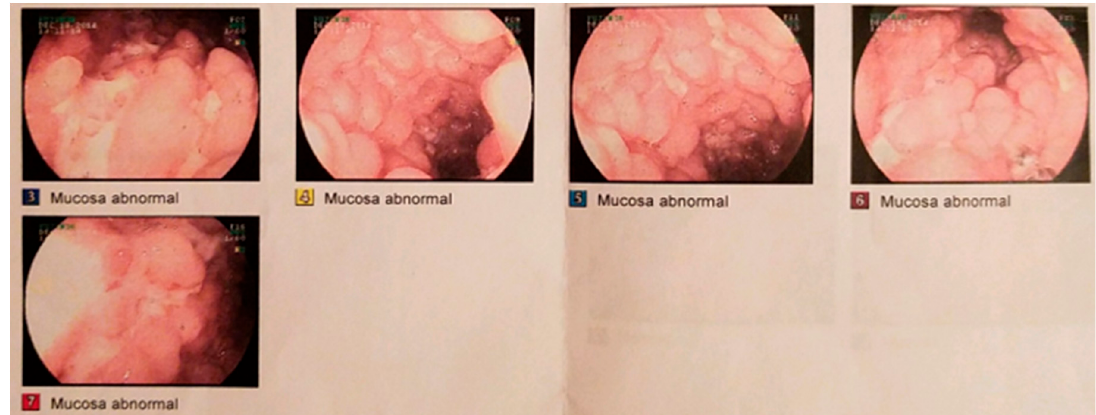
Figure 1. Photographs from diagnostic ileo-colonoscopy in December 2014: inflamed terminal ileum with the typical cobble stone mucosa and ulceration of Crohn’s disease.